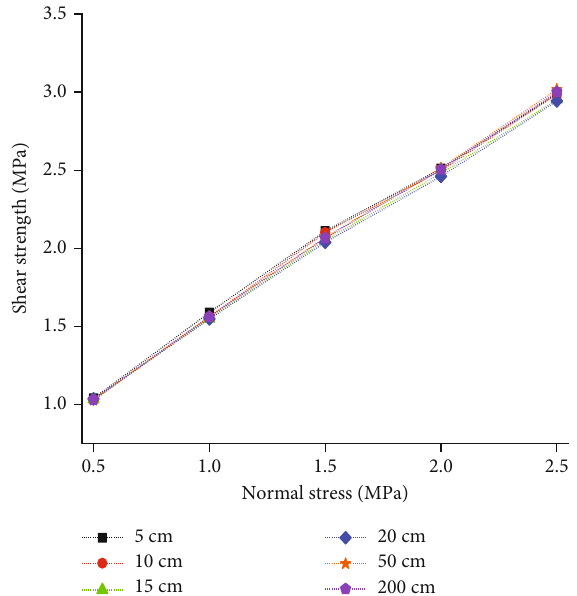
Figure 5: Relationship between shear strength and normal stress of joints with di ff erent sizes.